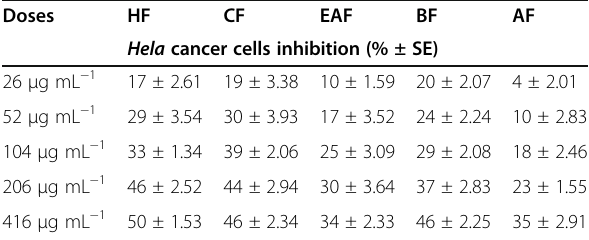
Table 1 Hela cancer cells inhibition due to the application of various solvent fractions of Moringa oleifera Doses HF CF EAF BF AF Hela cancer cells inhibition (% ±